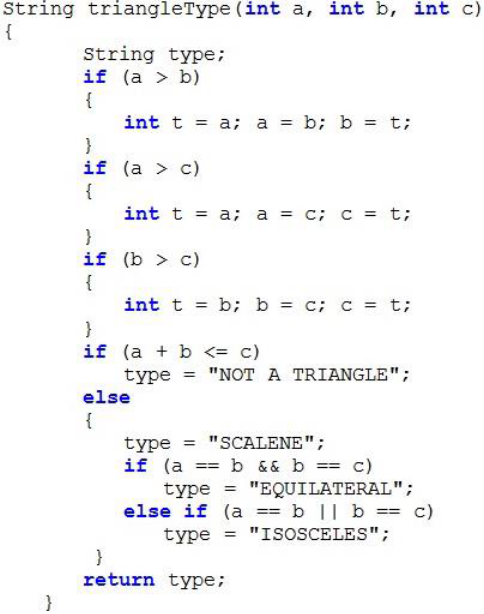
Figure 4. The triangle type